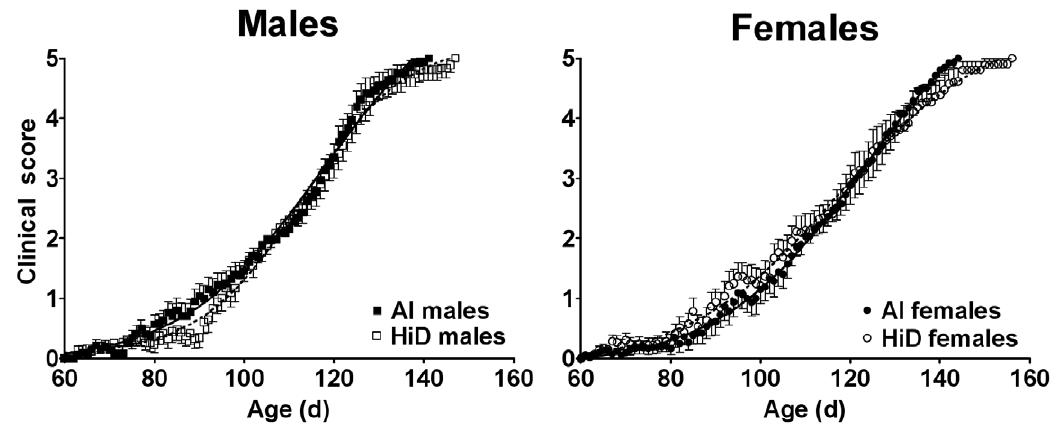
N , 13 females) and 28 high (HiD; 50 IU D 3 /